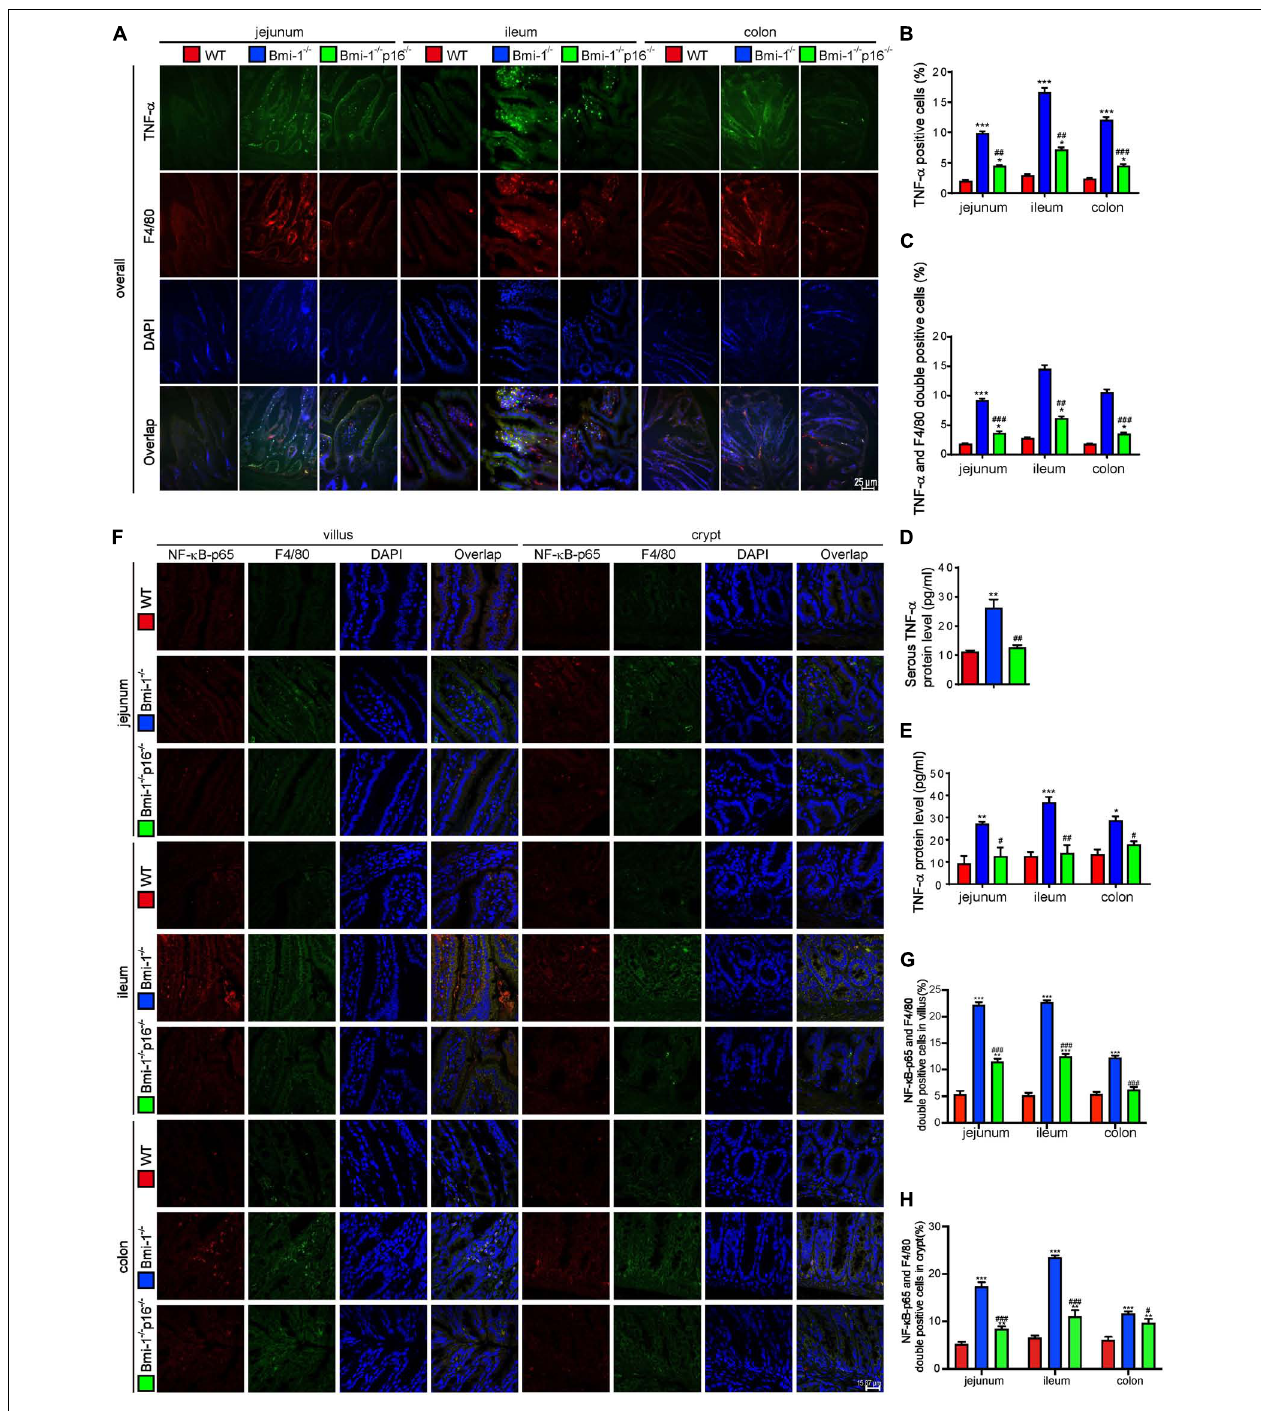
FIGURE 5 | P16 deletion improved TNF- α –dependent epithelial barrier destruction in Bmi-1 − / − mice. The experiments were carried out on the 7-week-old Bmi-1 − / − , Bmi-1 − / − p16 − / − , and WT mice. (A) Representative micrographs showing immunofluorescence for TNF- α and F4/80, with DAPI staining the nuclei. (B) Percentage of TNF- α –positive cells. (C) Percentage of TNF- α and F4/80 double-positive cells. (D) Serous TNF- α protein level (pg/mL) was detected with ELISA assay. (E) TNF- α protein levels in jejunum, ileum, and colon (pg/mL) were detected with ELISA assay. (F) Representative micrographs showing immunofluorescence for NF- κ B–p65 and F4/80, with DAPI staining the nuclei. (G,H) Percentage of NF- κ B–p65 and F4/80 double-positive cells or areas in villus and crypt. Six mice per group were used for experiments. Statistical analysis was performed with one-way ANOVA test. Values are mean ± SEM from six determinations per group, * p < 0.05, ** p < 0.01, *** p < 0.001 compared with the WT group; # p < 0.05, ## p < 0.01, ### p < 0.001 compared with the Bmi-1 − / − group.